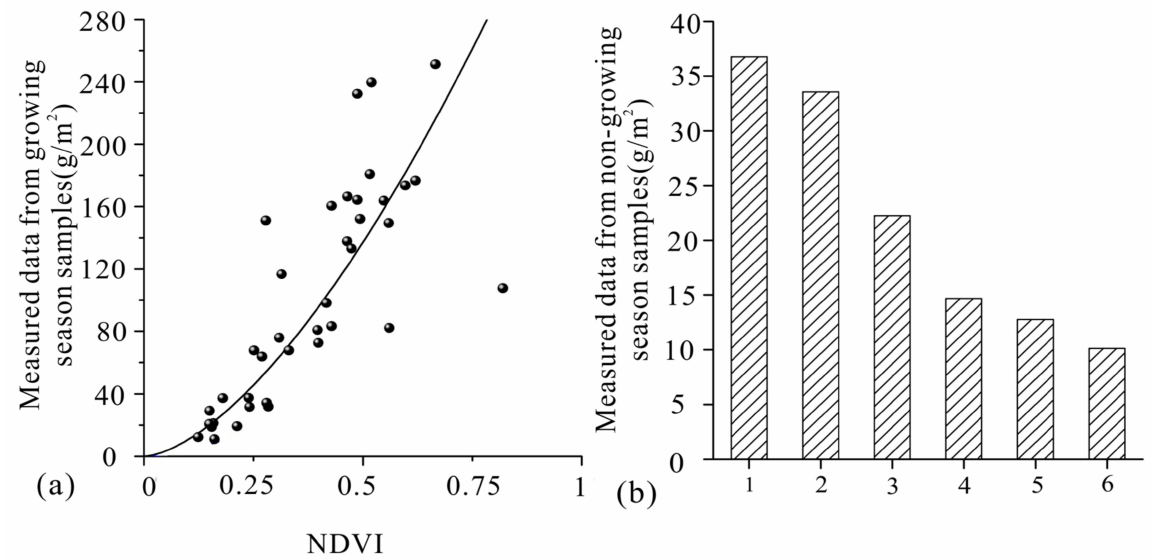
Figure 2. Simulated and measured aboveground biomass in the growing season model at the sample scale ( a ), and monthly decreasing trend of dead leaves in the nongrowing season at the sample scale ( b ) (j represents November–April of the following